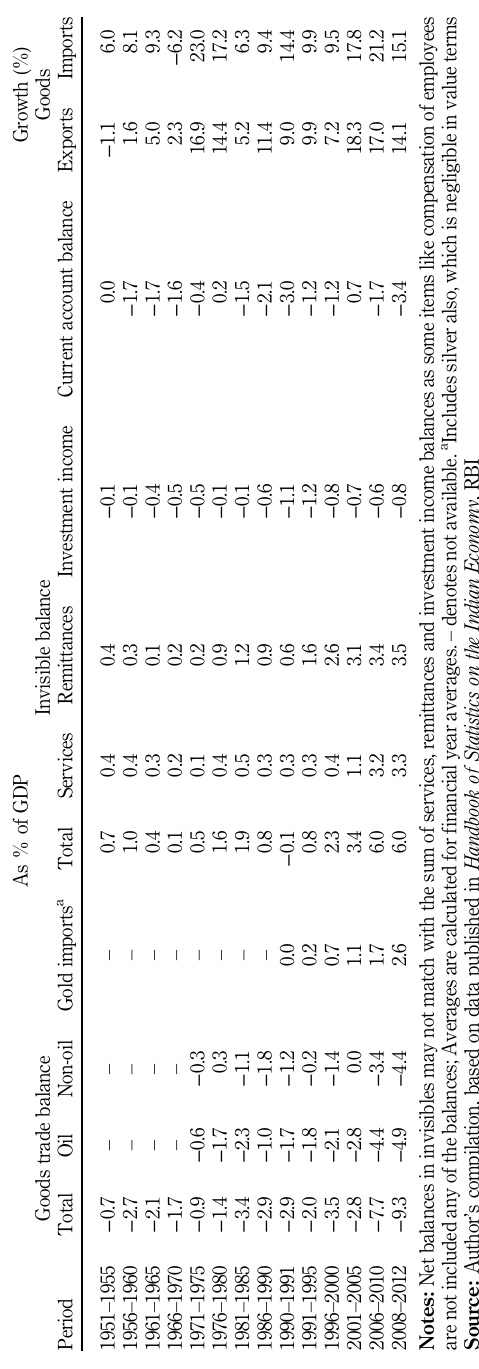
Table I. Evolution of India ’ s current